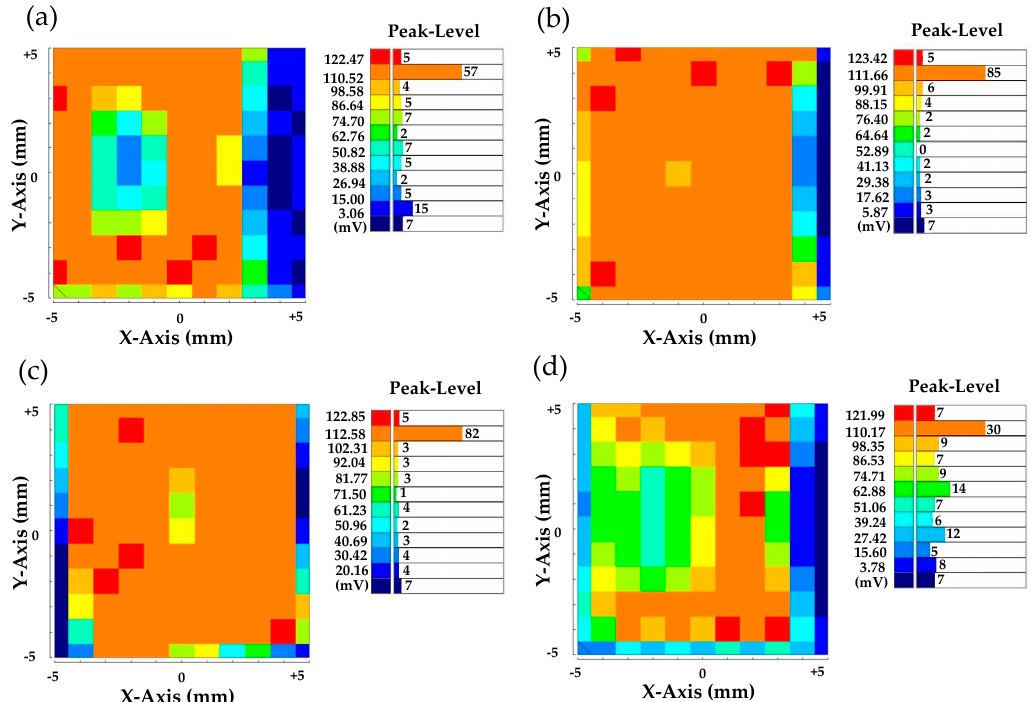
Figure 8. Peak mapping results of ( a ) the unannealed PrIZO thin film and PrIZO thin films annealed at ( b ) 150 °C, ( c ) 250 °C, ( d ) 450 °C.